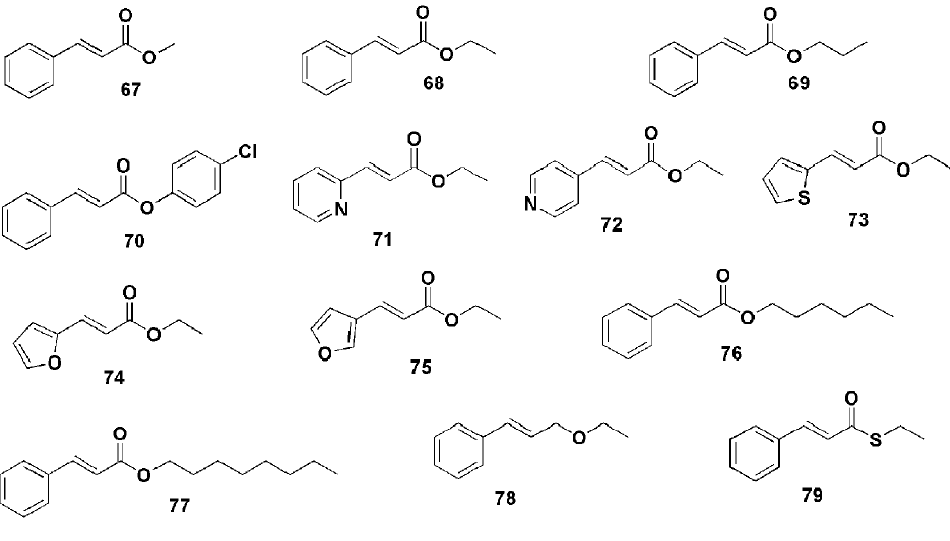
Figure 19. Chemical structures of compounds 67 – 79 [52].